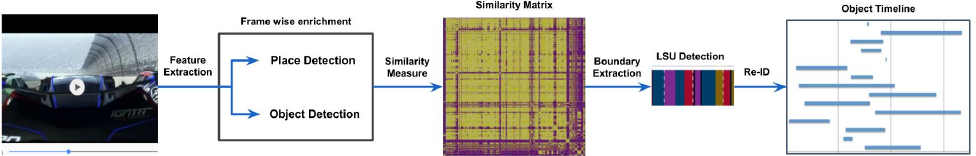
Figure 2. Overview of the proposed pipeline. Given the input video, the framework extracts visual features to obtain frame-level semantics. The enriched semantic information can then be used for search and retrieval of video segments, predict shot and scene boundaries, and also to create object timelines.